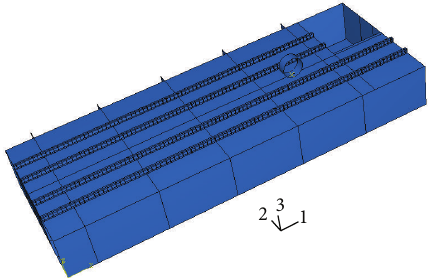
Figure 6: General view of model for slab strength evaluation.